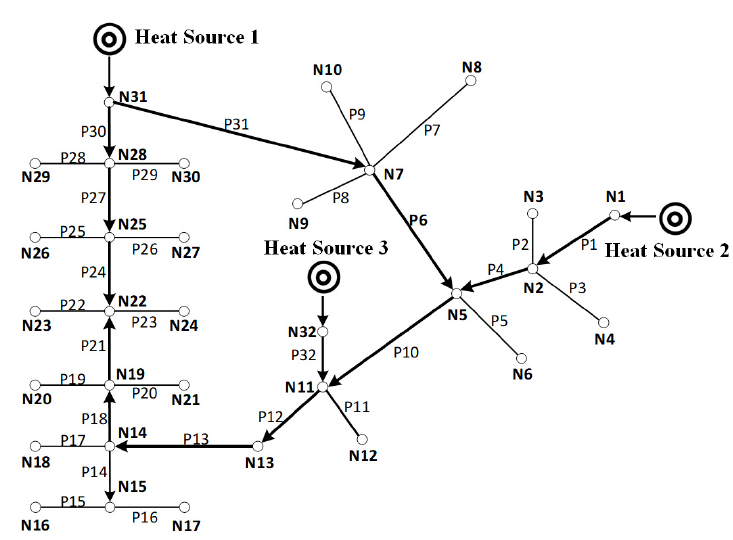
Figure 2. Bali 32-node heat grid model.